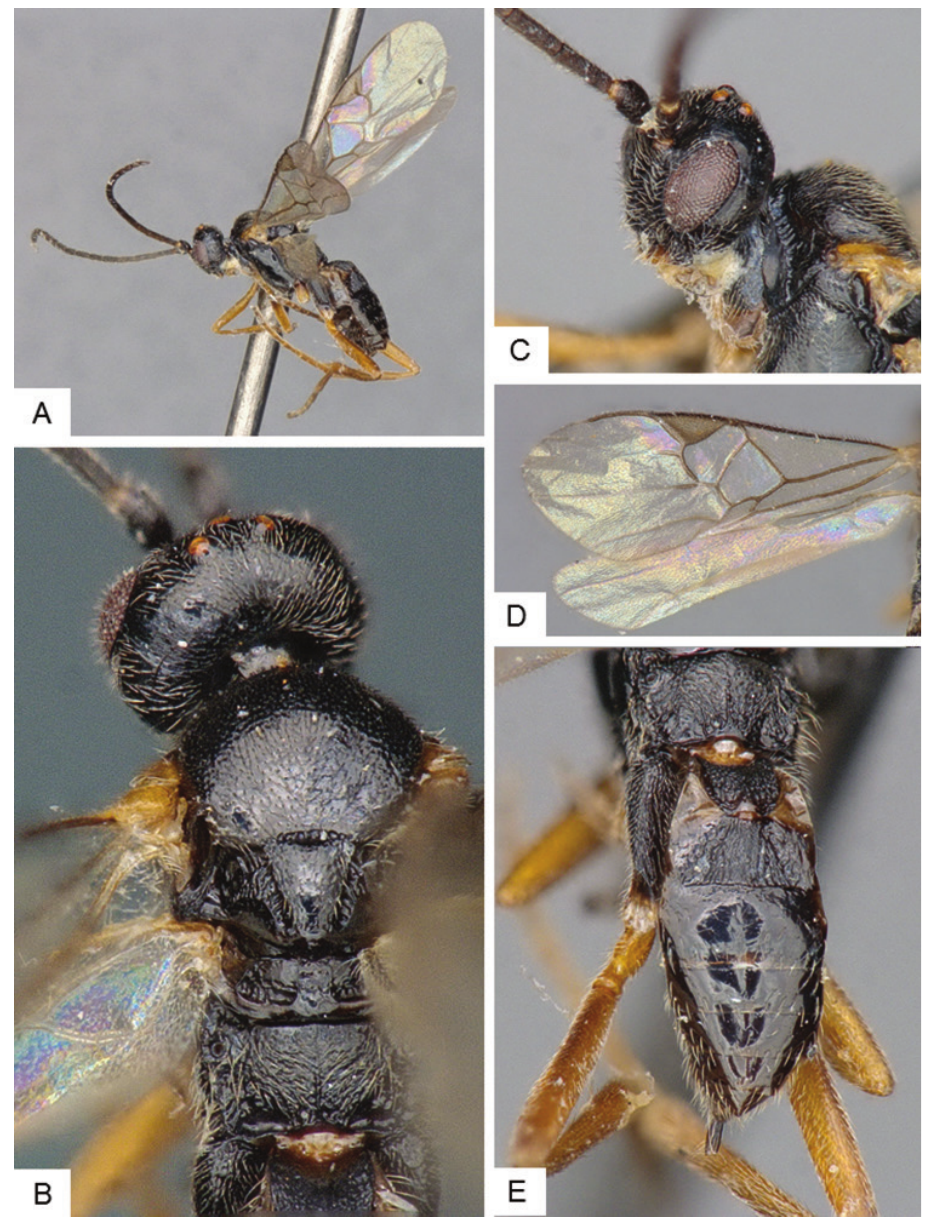
Figure 20. Glyptapanteles sp. 6. A Habitus, lateral B Head and mesosoma, dorsal C Head, lateral D Fore wing and hind wing E Metasoma,